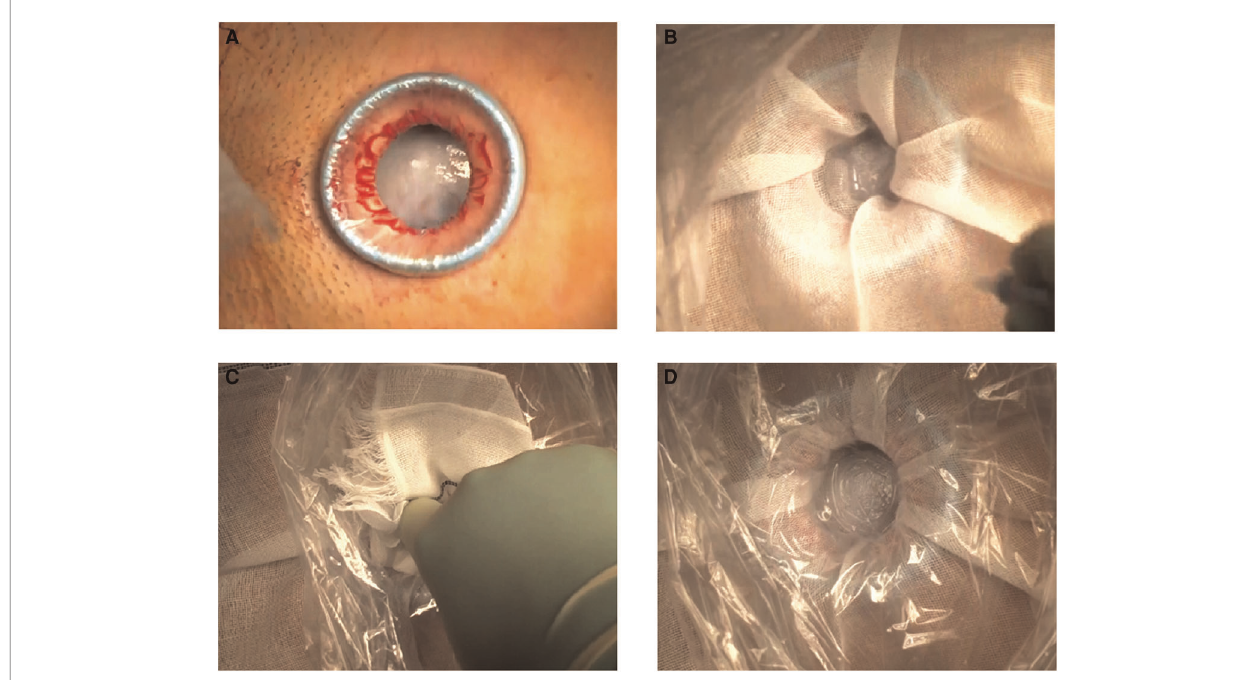
FIGURE 2 | Instant mounting of plastic wrap and gauze to the giant ovarian cyst. ( A ) Completion of the attachment of a wound retractor to the 3-cm lower abdominal transverse incision. ( B ) Condition immediately after applying cyanoacrylates on the cyst through the gauze. ( C ) Mounting the plastic wrap and gauze on the cyst. ( D ) Completion of the instant mounting to the cyst wall. The color of the adhesive has changed from transparent to white upon completion of cyanoacrylate